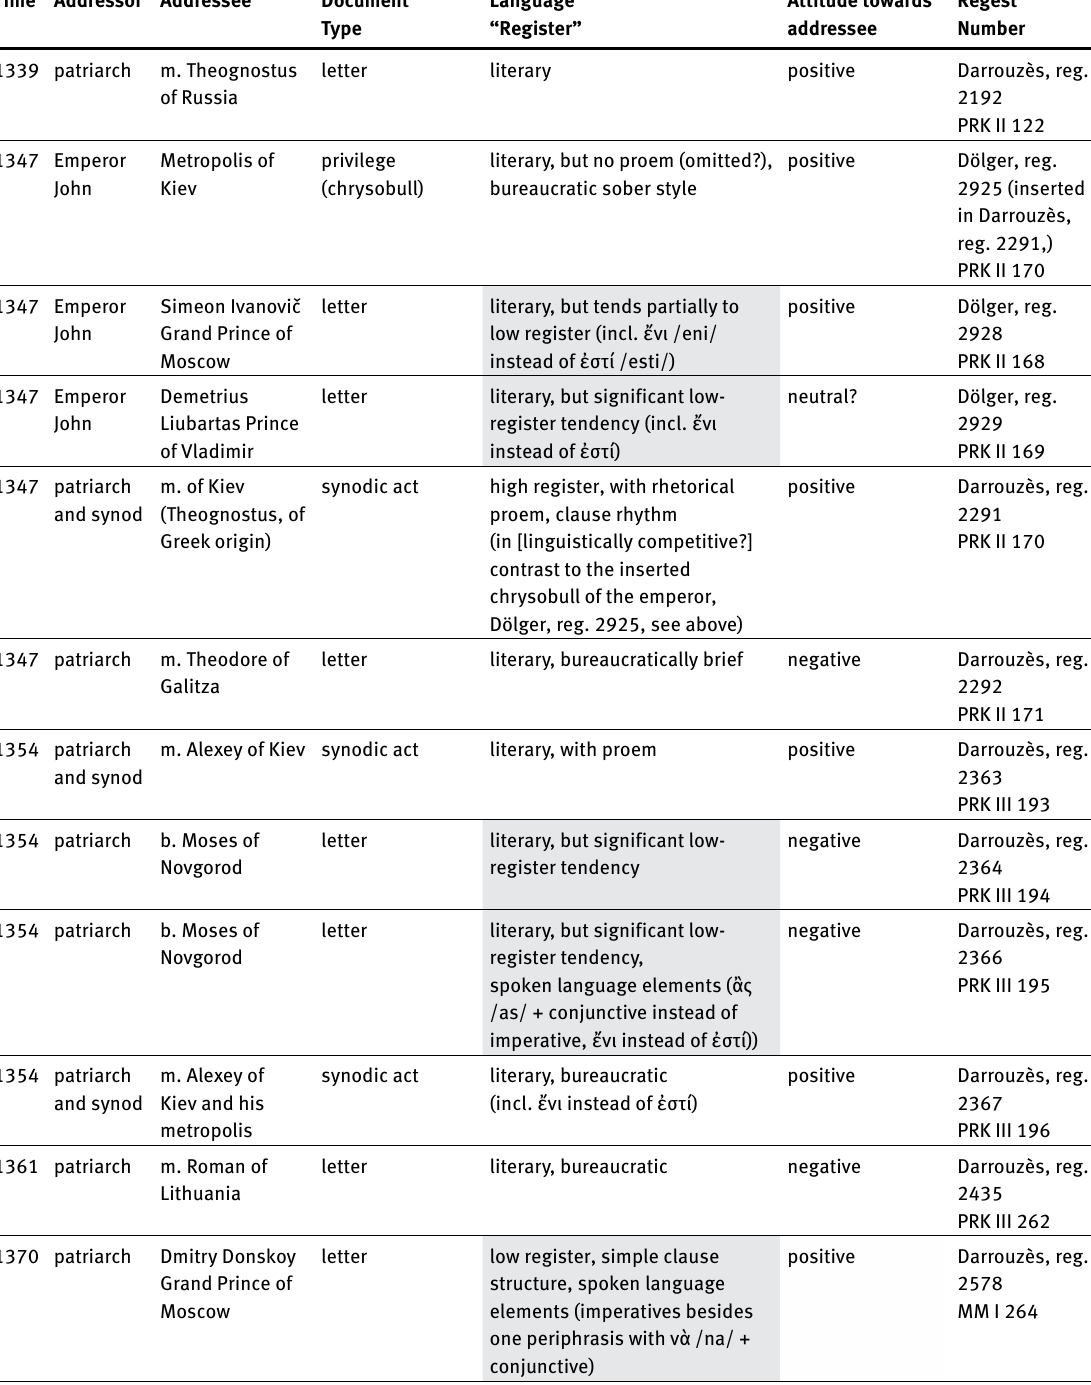
Table 1: Correspondence with “Russia” and “Poland”, outside the Byzantine Empire, but within the area of influence of the Patriarch of Constantinople, as documented in the patriarchal register (analysis based on the list of documents in Hinterber- ger [2005: